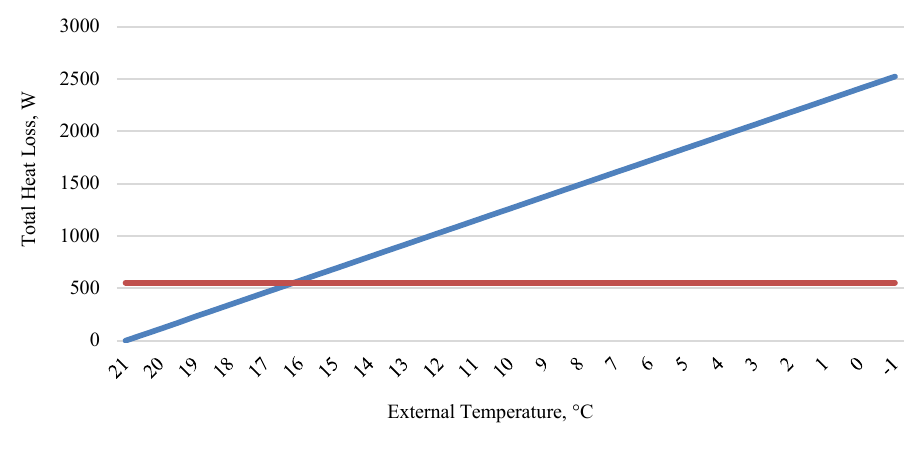
Fig. 1. Calculation of balance temperature for building 7 in January